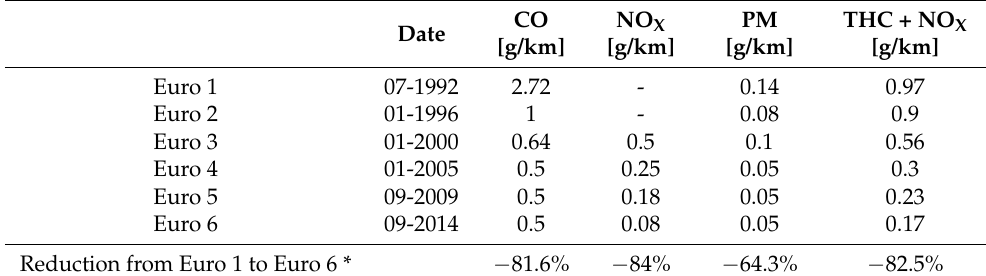
Table 1. Pollutant vehicle emissions from Euro 1 to the last Euro 6. * In the case of NOx, since